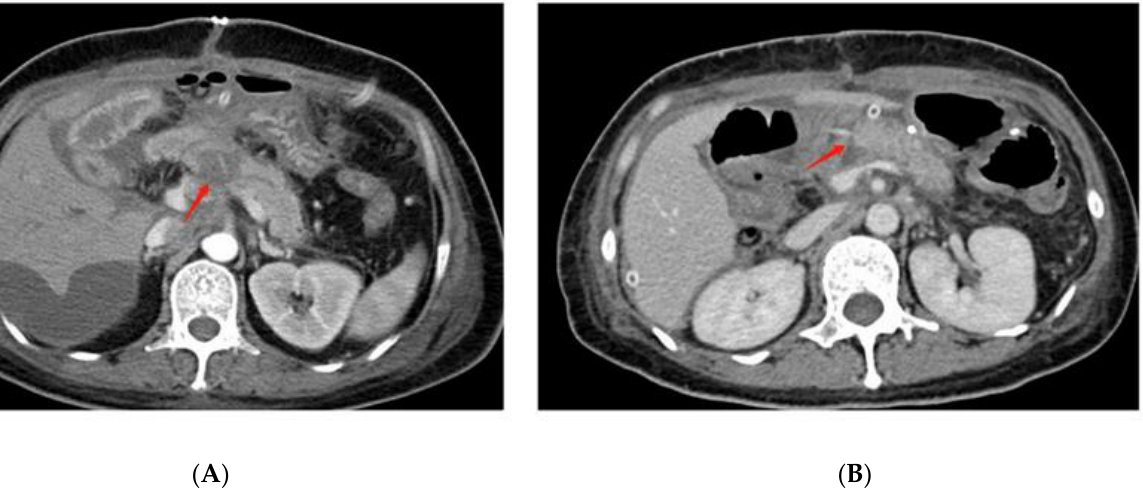
Figure 2. Postoperative CT findings of grade C POPF. ( A ) shows the complete dehiscence of the pancreaticojejunostomy at the red arrow. ( B ) shows the crevice of the pancreaticojejunostomy at the red arrow.